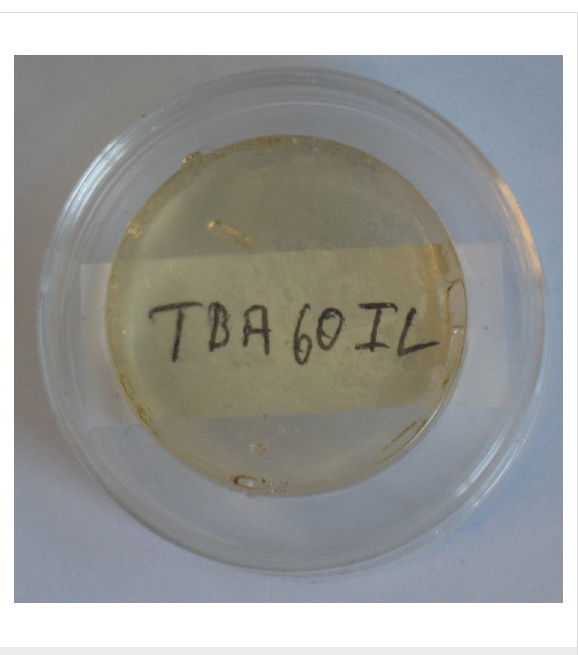
Figure 7: Photograph of an IG resulting from the combination of the TBA60 organosilica matrix and [BmimSO 3 H][PTS].